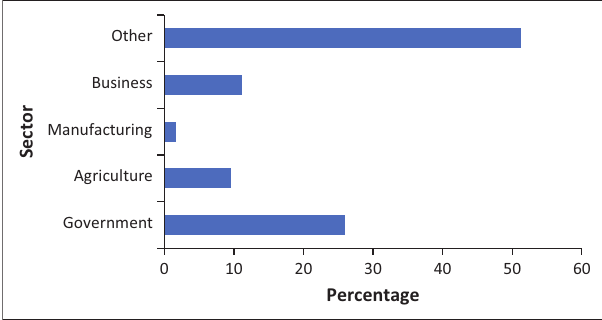
FIGURE 5: Sectors in which participants work.